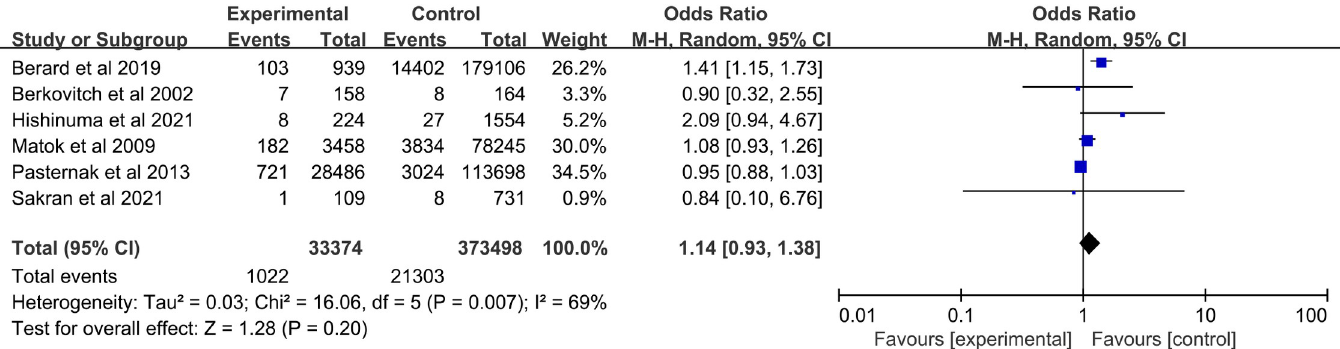
Fig 2. Forest plot of the association between metoclopramide use during the first trimester and the risk of major congenital malformations.